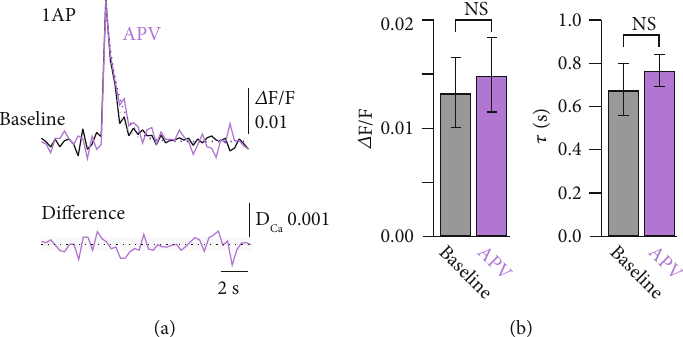
Figure 4: APV has no in fl uence on presynaptic AP-evoked Ca 2+ transients. (a) Axonal Ca 2+ transients evoked by a single AP in a spiny stellate axon recorded in L2/3 during baseline (black) and in the presence of the NMDAR blocker APV (purple). Dashed lines represent single exponential fi ts to the decay of the Ca 2+ transients. Lower trace represents the di ff erence between the baseline and APV Ca 2+ transients. Dashed line indicates zero and light shaded area indicates the baseline noise level ( ± SD). (b) Bar graph summary of the peak Ca 2+ transient amplitudes (left) and decay time constants (right) for baseline and in the presence of APV. All data are represented as mean ± SEM